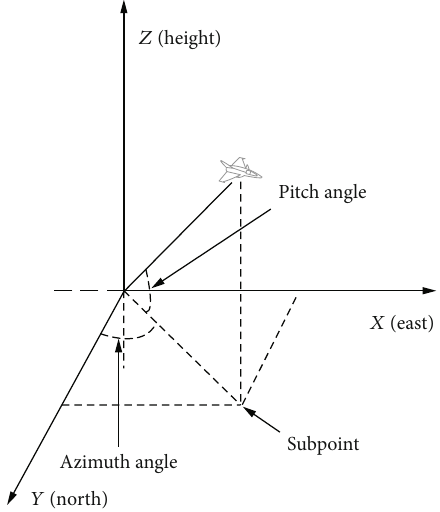
Figure 1: Radar tracking system ENU coordinate